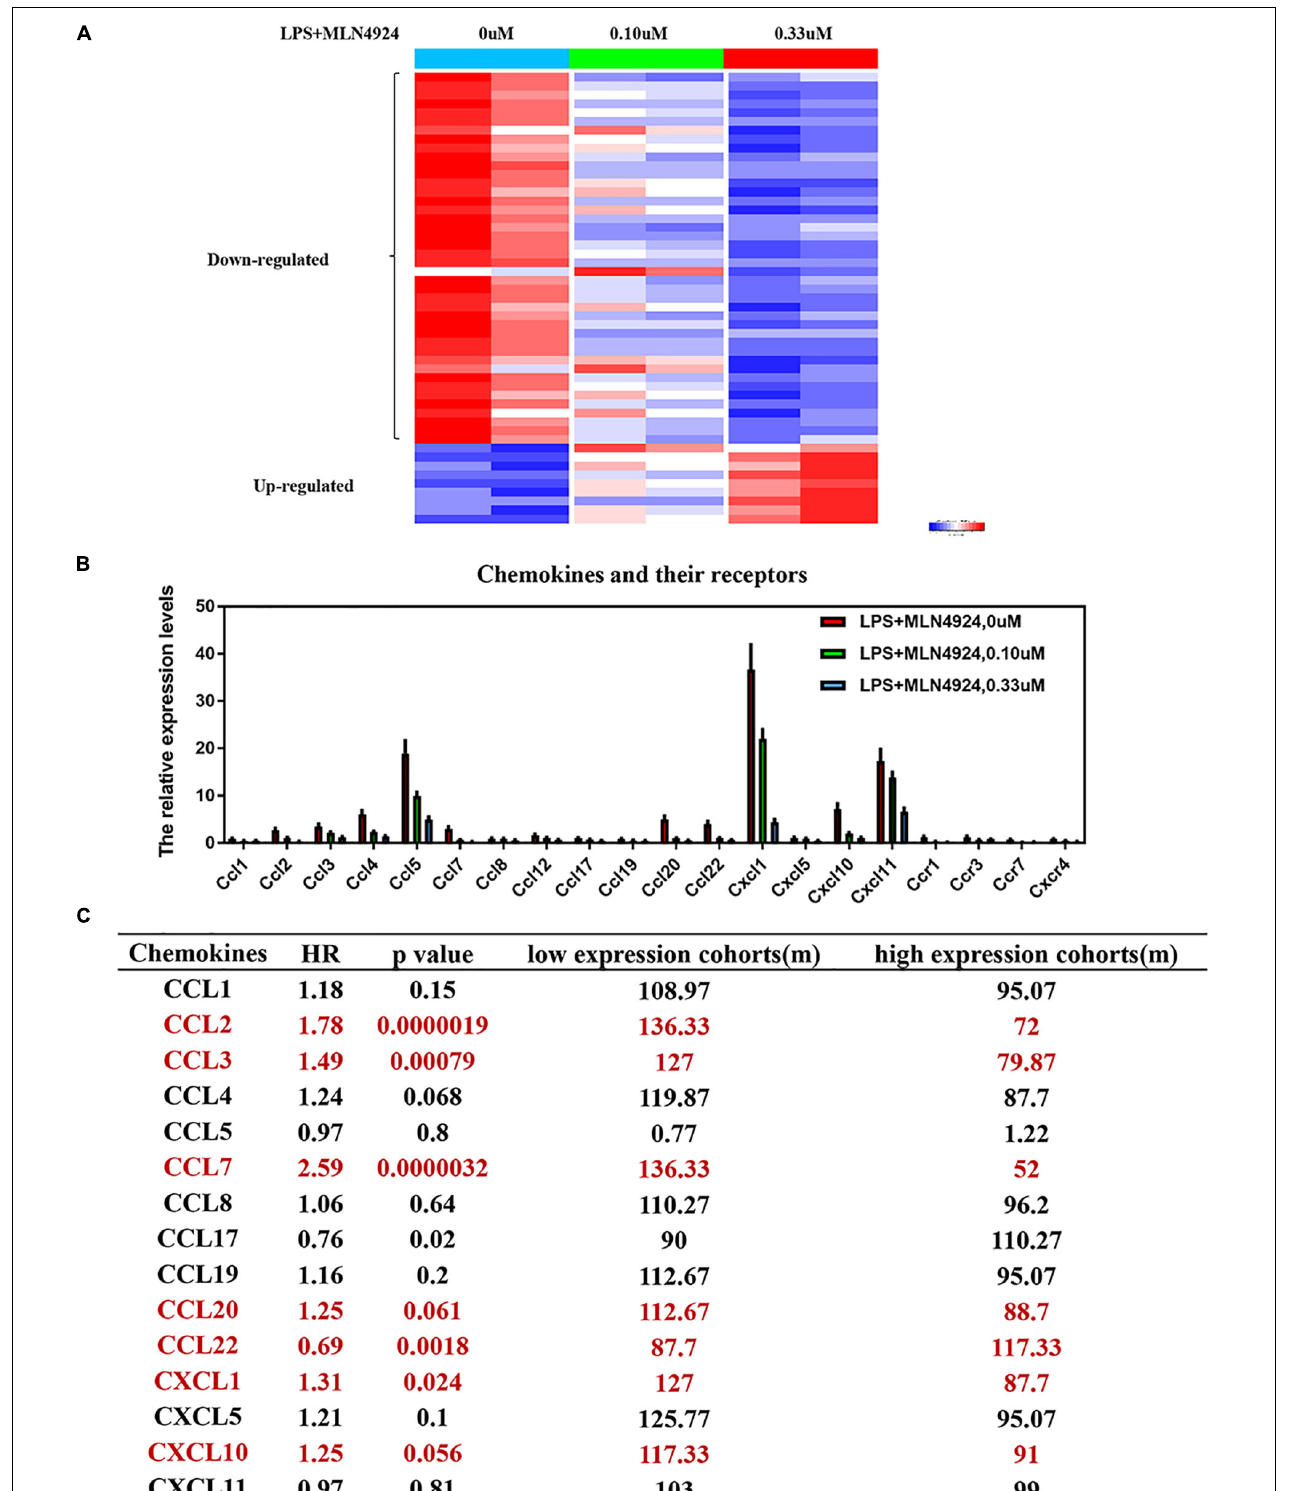
FIGURE 2 | Neddylation regulates the release of inflammatory cytokines in macrophages. (A) The results of PCR array analysis on lipopolysaccharide (LPS)-treated RAW264.2 upon MLN4924 treatment, (B) MLN4924 treatment decreases the level of chemokines and the related receptors in lipopolysaccharide (LPS)-treated RAW264.2. (C) The survival analysis of these chemokines in lung adenocarcinoma using KM plotter website.